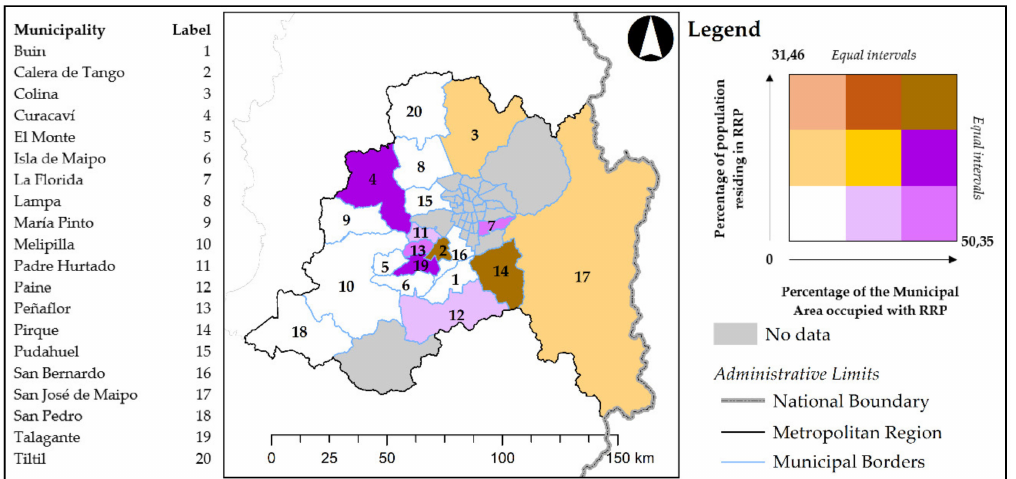
Figure 4. Percentage of municipal (county) surface occupied by RRP and municipal (county) population living in RRPs. Source: Own elaboration, based on INE (2017) and MINVU (2020).